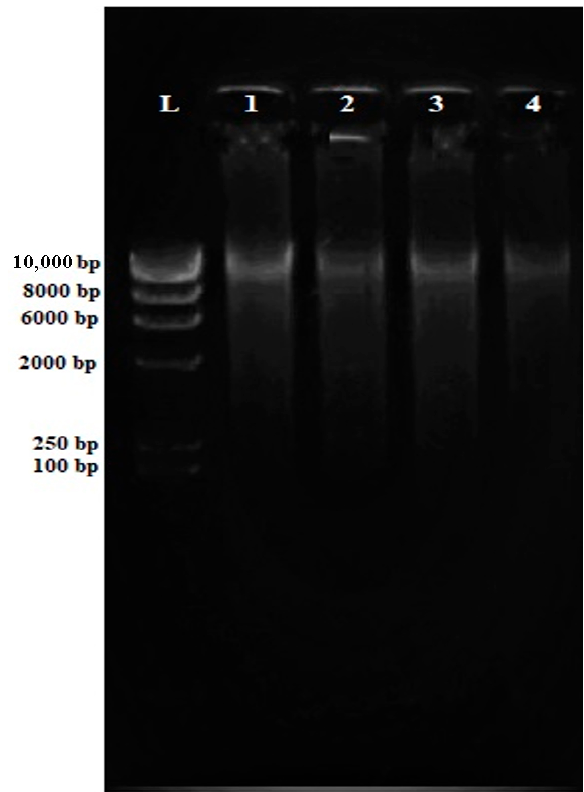
Figure 1. Electrophoresis gel (0.8% agarose) of the extracted genomic DNA from MRSA isolates. All genomic MRSA DNA (Lane 1–Lane 4) are intact for downstream applications.